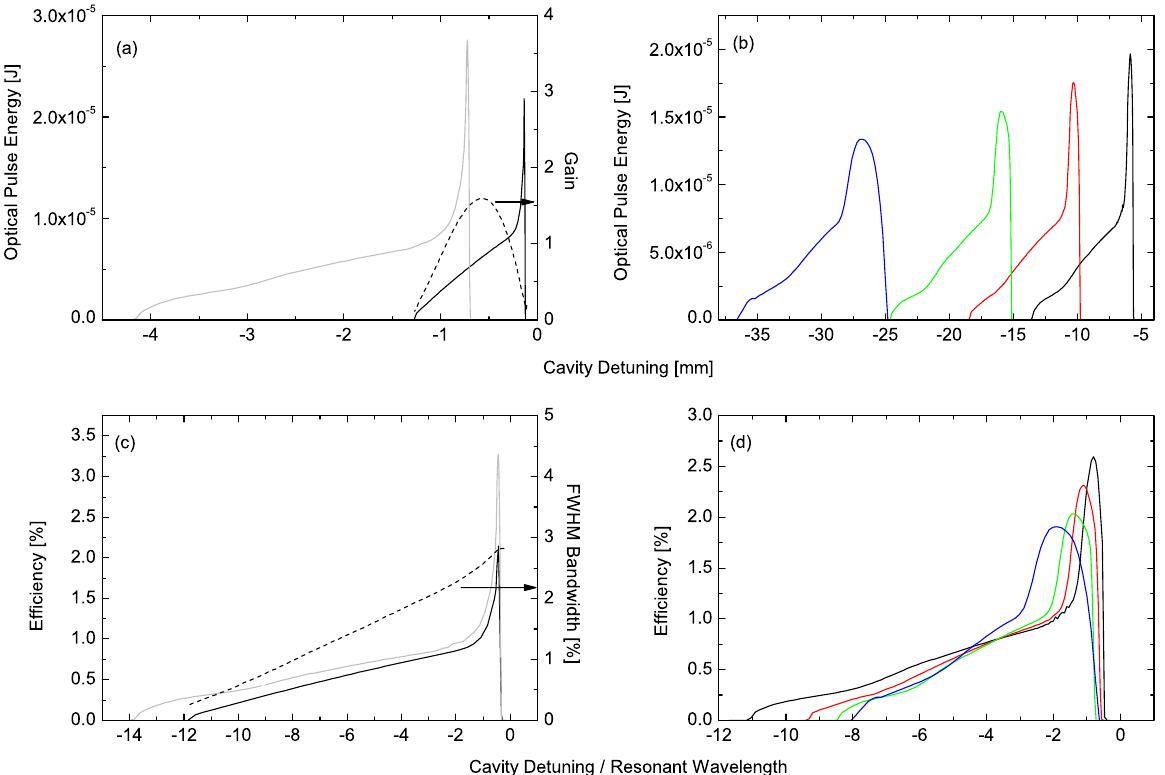
FIG. 2. The left and right sides of the figure correspond to the results obtained at the short resonant wavelengths of 100 (cid:1) m (black curve) and 256 (cid:1) m (gray curve), and for the long resonant wavelengths of 748 (cid:1) m (black curve), 990 (cid:1) m (red curve), 1230 (cid:1) m (green curve), and 1592 (cid:1) m (blue curve), respectively. (a),(b) Detuning curves obtained after averaging over 50 oscillator passes at the end of the macrobunch. (c),(d) The FEL efficiency at saturation versus different detuning values and for each curve (cid:5)L values are t = 2 , where v is the group velocity divided by the corresponding resonant wavelength. (cid:5)L ¼ 0 corresponds to the cavity length of v g b g found according to Eq. (3) for a given (cid:2) and t is the period between successive electron bunches multiplied by 150. The dashed r b ¼ 100 (cid:1) m in the curves in (a) and (c) depict the electronic gain and FWHM optical pulse bandwidth, respectively, calculated at (cid:2) r small-signal regime. The scales for the gain and bandwidth are shown on the right side abscissa in (a) and (c), respectively.